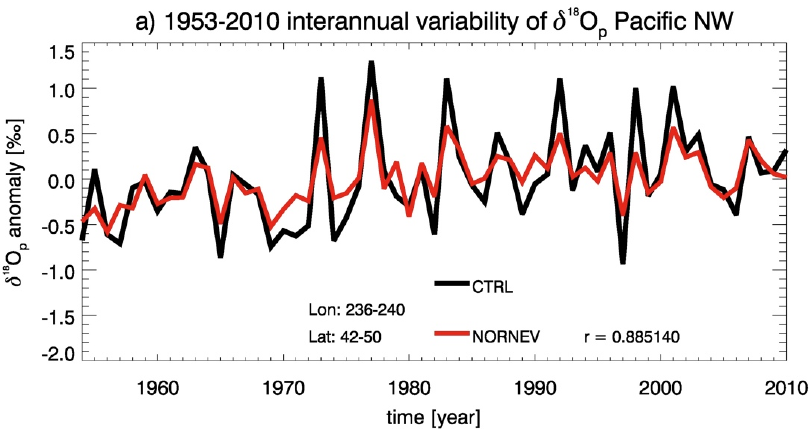
Figure 3. Regional average interannual time series of δ 18 O simulations. The panels display the ( a ) Pacific Northwest; ( b ) the interior of the western U.S.; ( c ) and central/southern